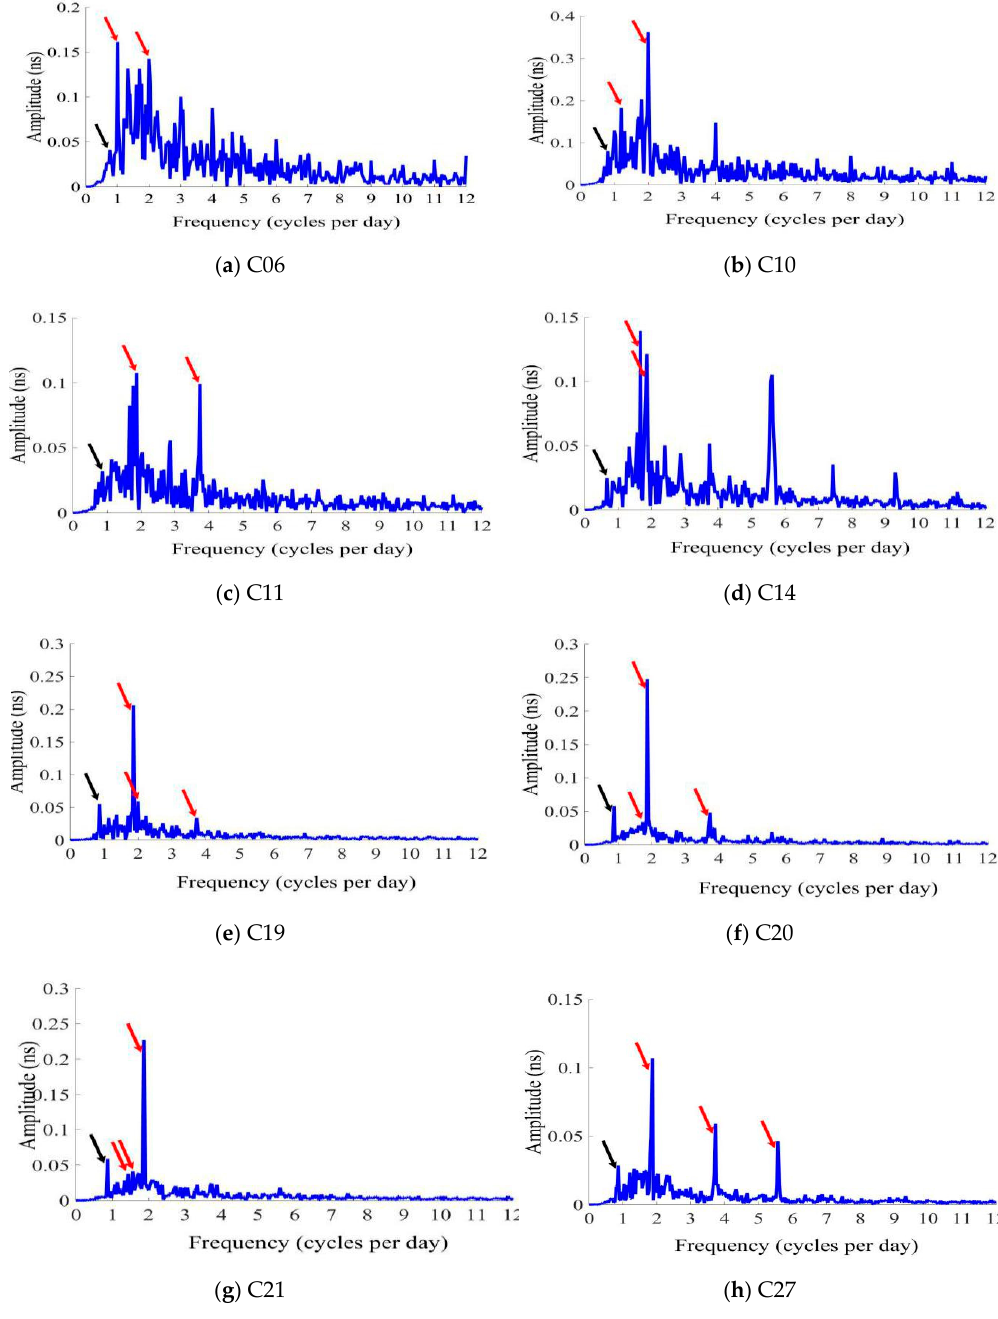
Figure 1. Frequency analysis of eight BeiDou demonstration system (BDS) satellites (black arrow is period term beyond one day; red arrow is the significant periodic terms in one day).